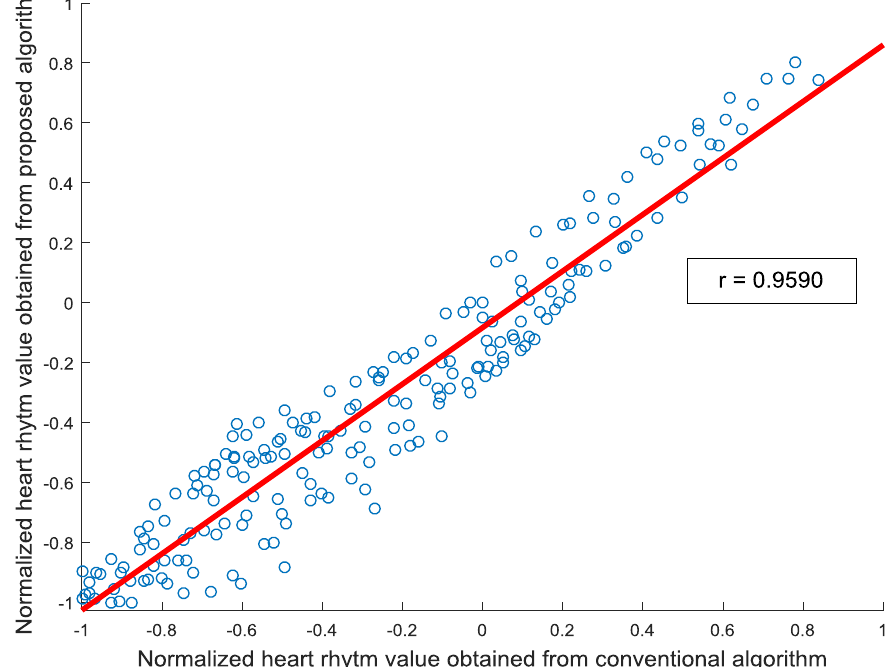
Figure 10. An example of the correlation between heart rhythms obtained from the proposed fingertip curve line movement-based and the conventional heart rate detection methods for subject 2. Here, the correlation line is denoted by the red solid line and the correlation index is 0.9590.